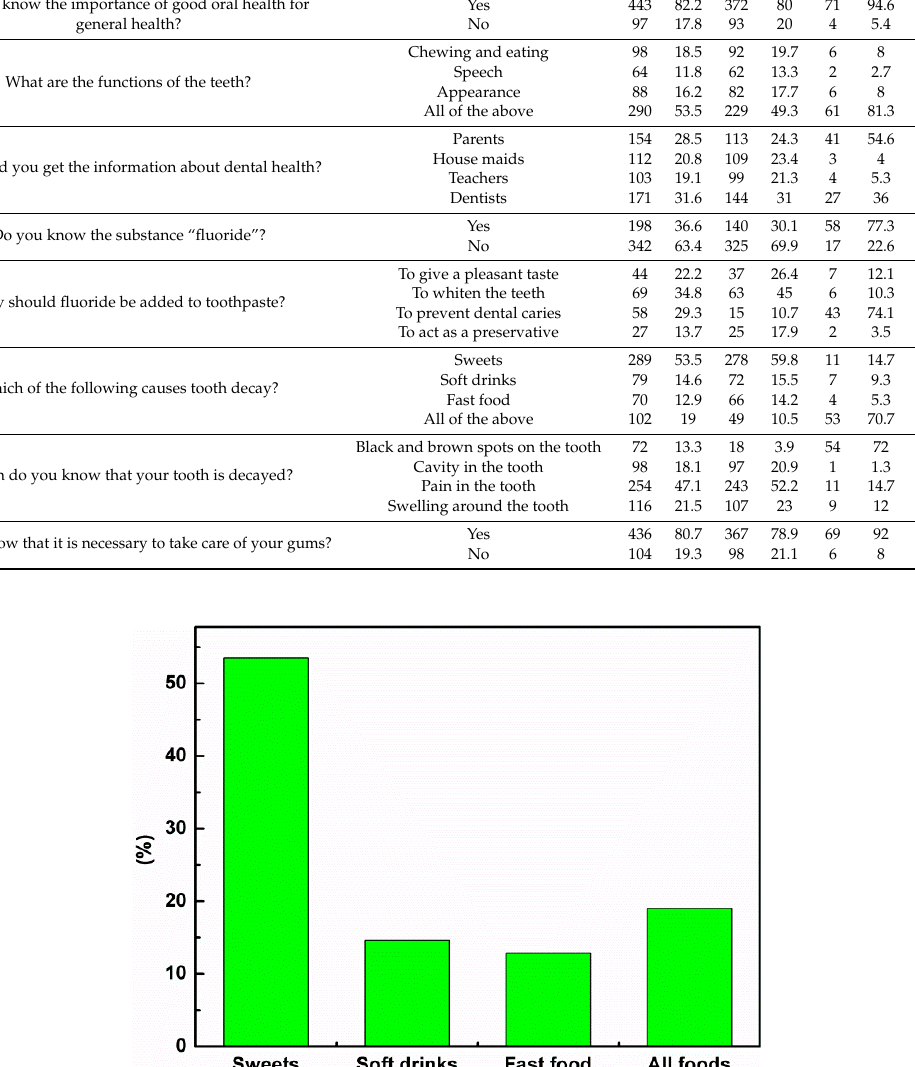
Figure 2. Causes of dental caries.